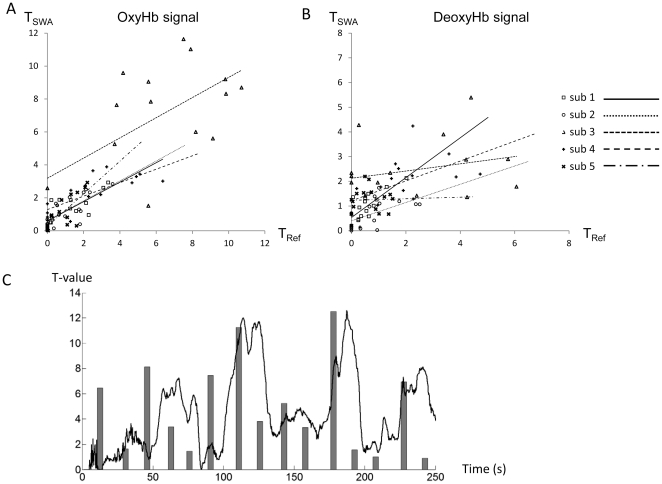
Comparison of calculated t-values from real-time processing and off-line processing.
A, B, Scatter plot of calculated t-values from real-time processing and off-line processing in five subjects using (B) OxyHb signal data and (C) DeoxyHb signal data. Using OxyHb signal data, all five subjects exhibited significant correlations between real-time assessments of cortical activation calculated from sliding-window GLM analysis (TSWA) and reference cortical activation calculated from task-by-task GLM analysis (TRef). However, correlations between TSWA and TRef were less with DeoxyHb data. C, The dynamic change of cortical activation feedback, as calculated from sliding-window GLM analysis (black line) and reference cortical activations calculated from the task-by-task GLM analysis (gray bar) in Experiment 1 (data from a representative subject).